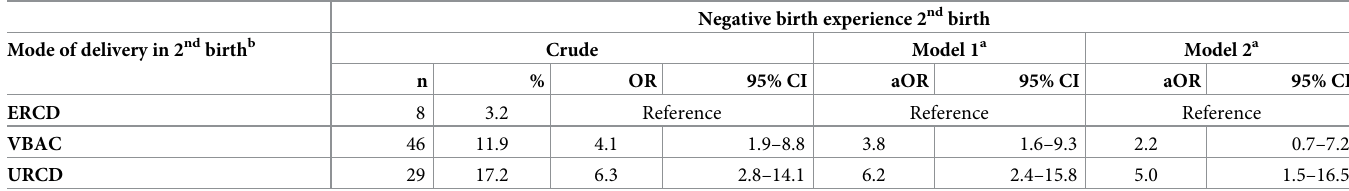
Table 3. Odds of negative birth experience by mode of delivery in 2 nd birth, logistic